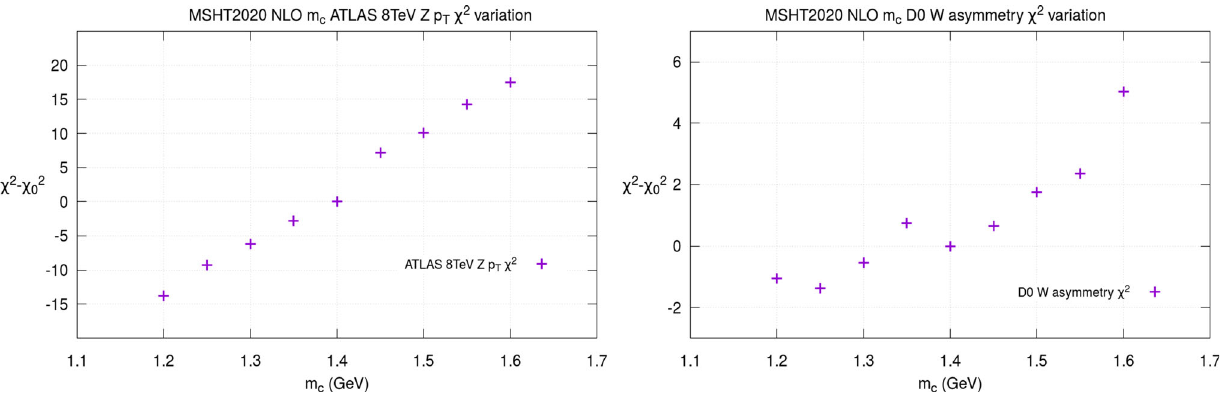
Fig. 14 The quality of the fit versus the quark mass m c at NLO with α S ( M 2 ATLAS 8 TeV Z data